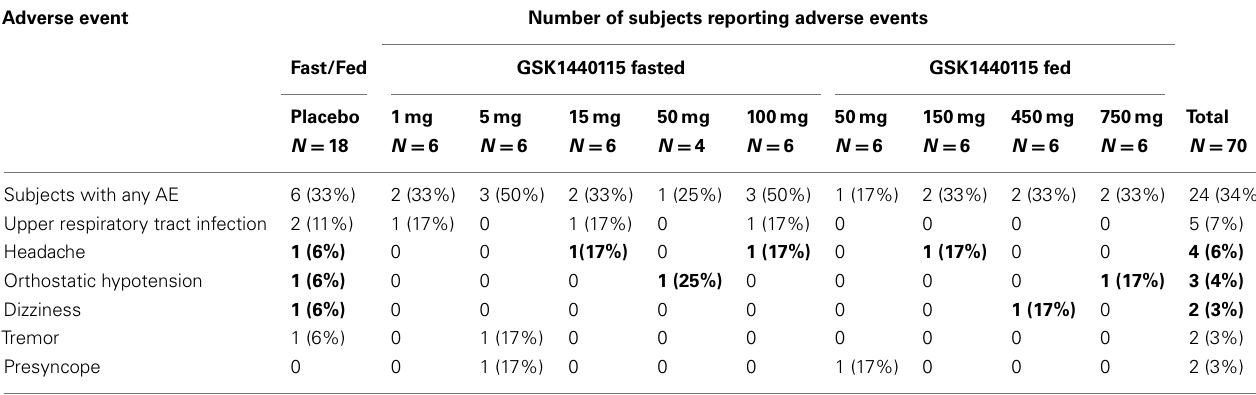
Table 2 | Summary of all adverse events (related and unrelated) in ≥ 2 subjects – phase I study in healthy volunteers. Adverse